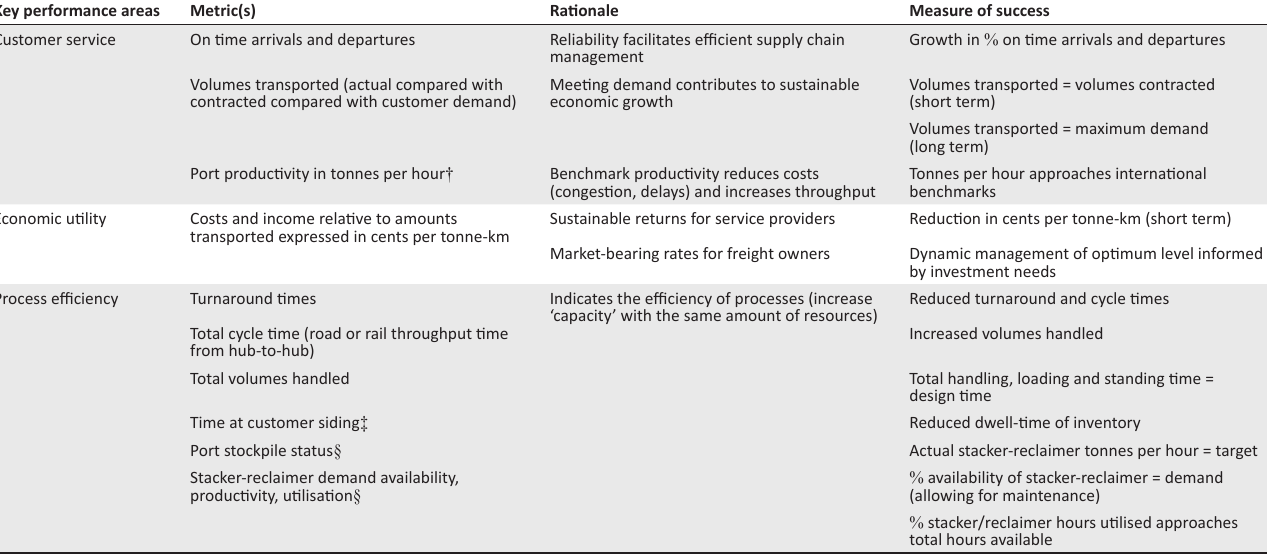
TABLE 4: Bulk export and multi-modal corridors – customer perspective key performance areas. Key performance